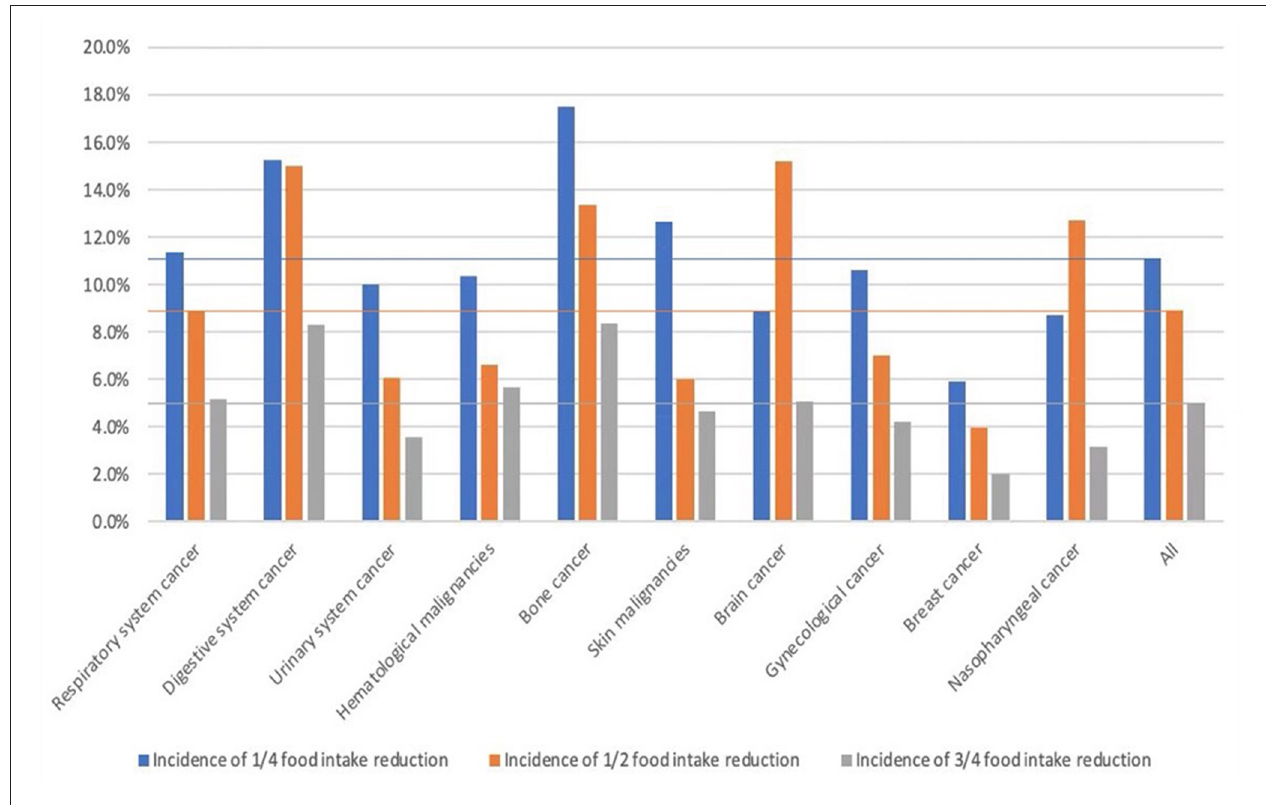
FIGURE 3 | Incidence of different degree of food intake